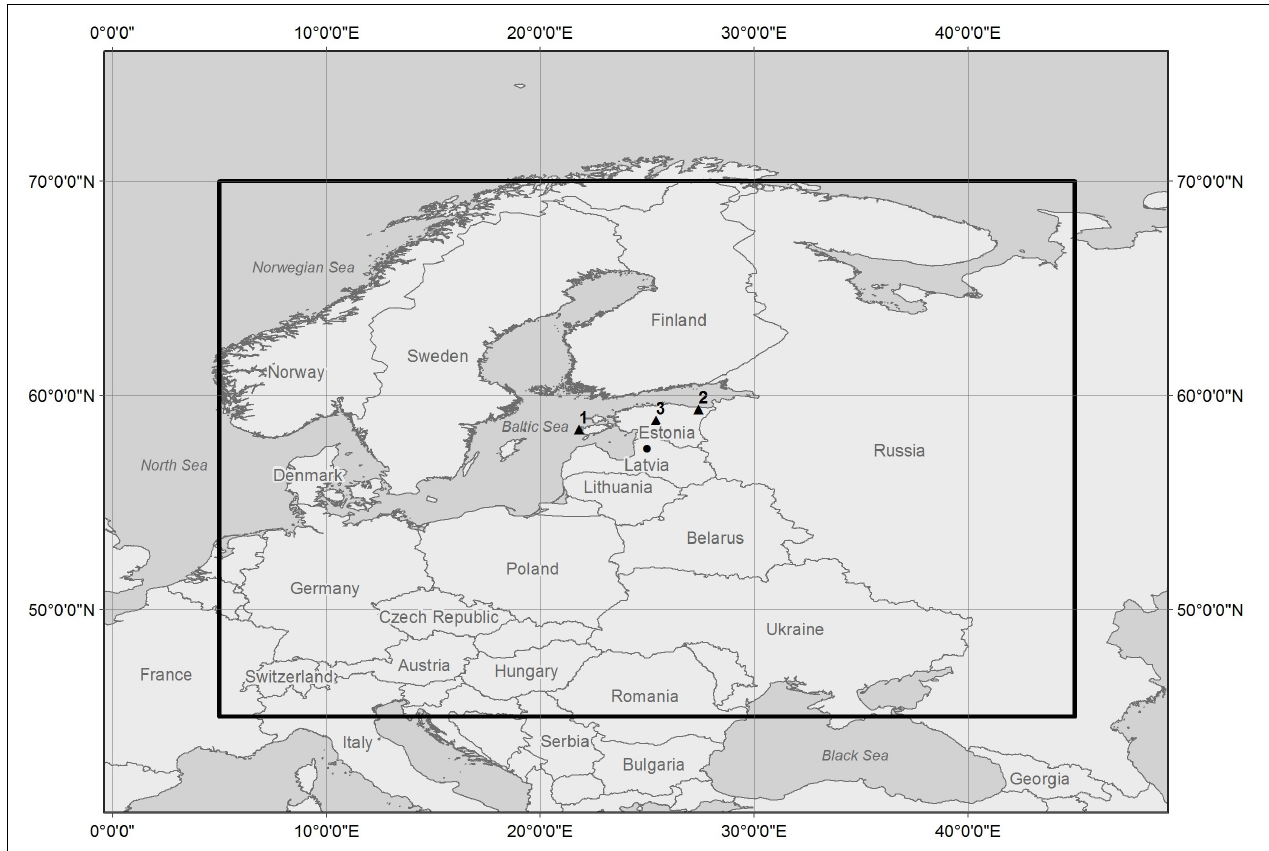
FIGURE 1 | Study area. Dark line: the border of the domain. Black dot: the center of the domain. Triangles: positions of meteorological stations (1, Vilsandi; 2, Jõhvi; 3, Türi).